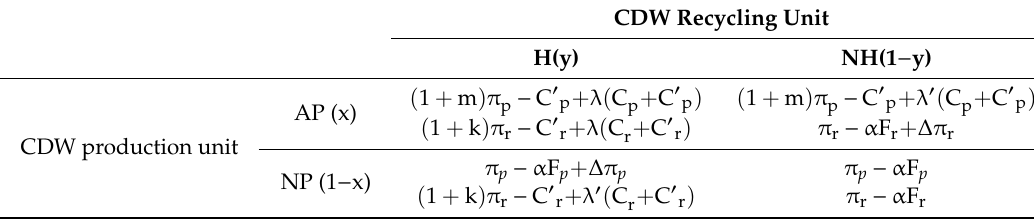
Figure 1. The cash flows for the construction and demolition waste (CDW) supply chain model. Table 2. The payoff matrix between a production unit and a recycling unit.